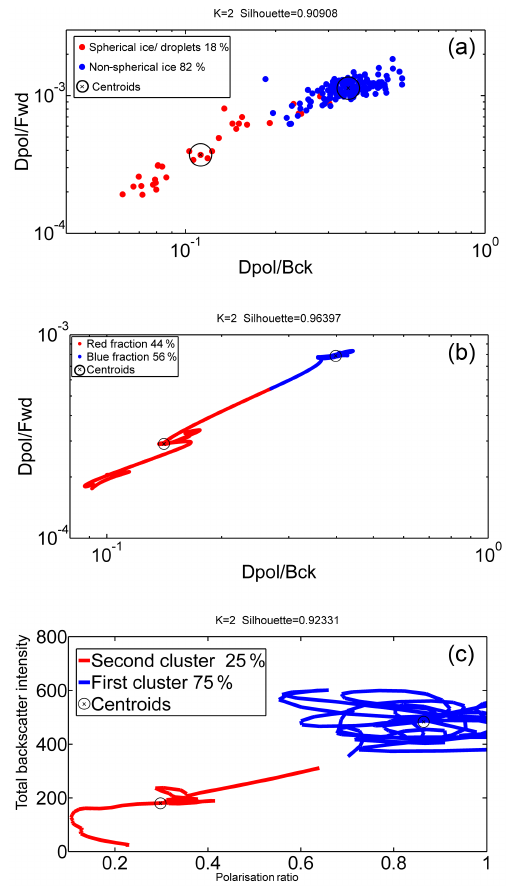
Figure 3. Cluster analysis (Run no. 1291.16). K in the title indi- cates the number of clusters found with best silhouette value. Each cluster appears with a percentage of particles in it. The centres of clusters are marked by centroids (cid:12) . (a) 1s averaged data, whole size range, and all concentration, (b) particle-by-particle data clustering for selected size range and concentration thresholds, (c) particle-by- particle data clustering plotted in a space comparable to Glen and Brooks